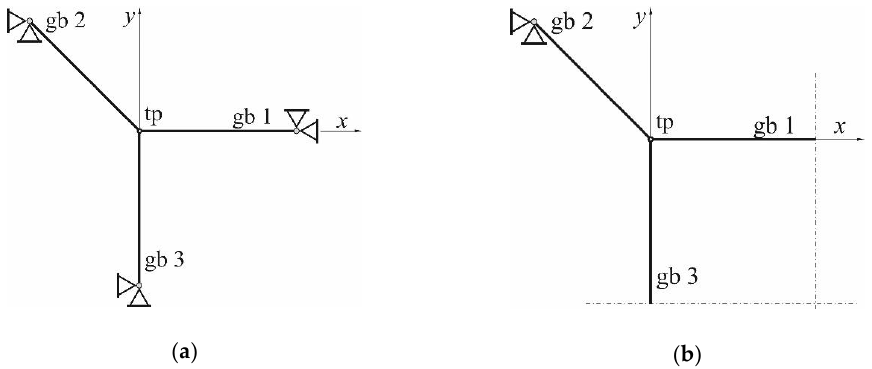
Figure 1. Initial arrangement of the grain boundaries (gb) 1, 2, and 3 at the triple point (tp): ( a ) The grain boundaries are fixed at their centers. These boundary conditions are strictly valid only for infinitely large grains. ( b ) The left and the upper half of gb 1 and gb 3 are confined by the upper left quarter of an initially quadratic grain. Symmetric boundary conditions are applied to the center of gb1 and gb3.